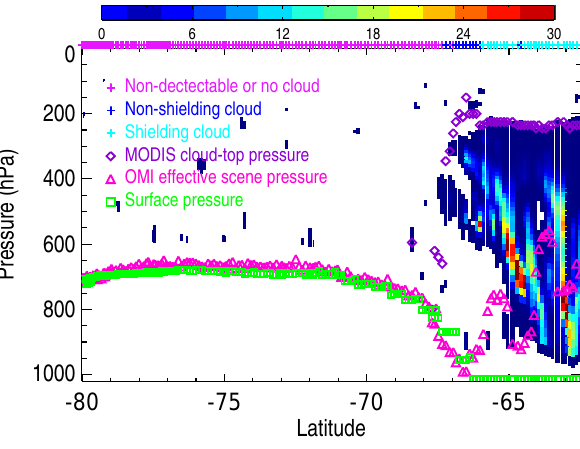
Fig. 9. CloudSat cross section of cloud extinction (upper color scale in km − 1 ) with various parameters retrieved from collocated OMI and MODIS data for OMI orbit 12394 on 13 November 2006. Results of the cloud classification are shown on the upper x -axis.